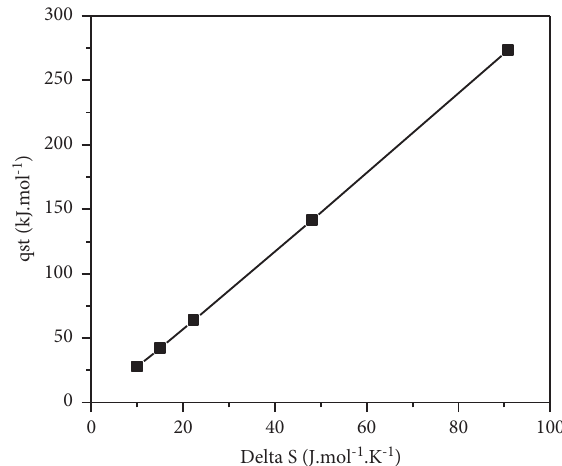
Figure 7: Enthalpy-entropy compensation theory for the water adsorption processes in SCP.